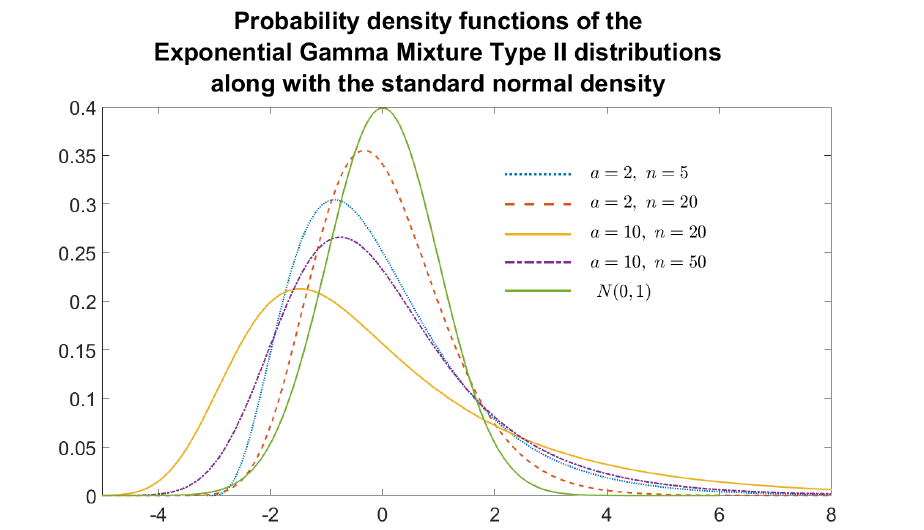
Figure 10: The convergence to the N (0, 1) limiting distribution is faster when a is